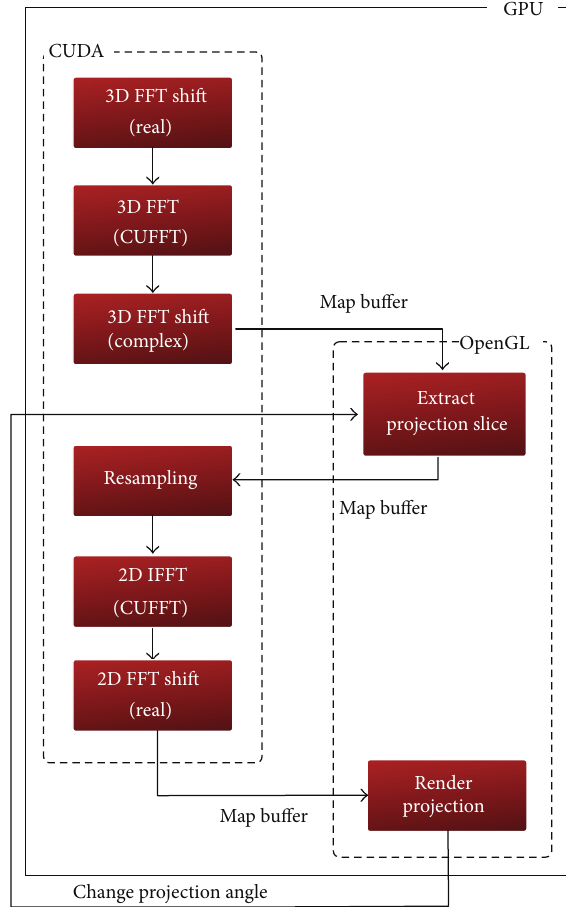
Figure 5: GPU-based implementation of the FVR pipeline. The rendering contexts of the hybrid implementation are reused and the computational one is reimplemented in a CUDA